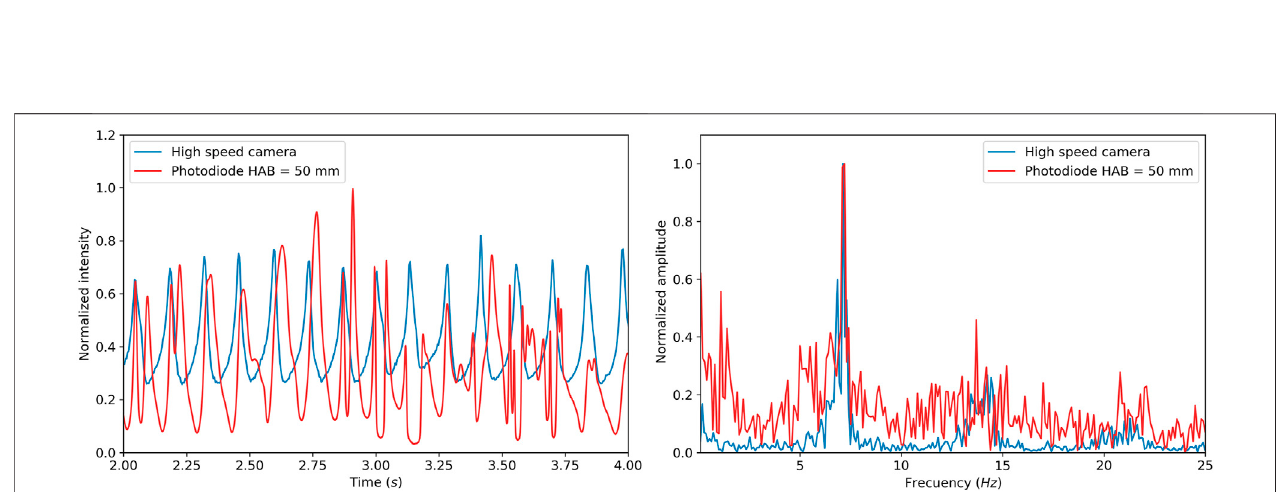
FIGURE 4 | Temporal evolution of fl ame emission at different spectral regions. The high speed camera detected at 800 ± 12.5 nm meanwhile the photodiode detects between 320 – 1,100 nm. On left: the integration of the high speed camera image intensity and the local photodiode signal at HAB (cid:1) 50 mm. On right: the Fast Fourier Transform analysis of the high speed camera and photodiode